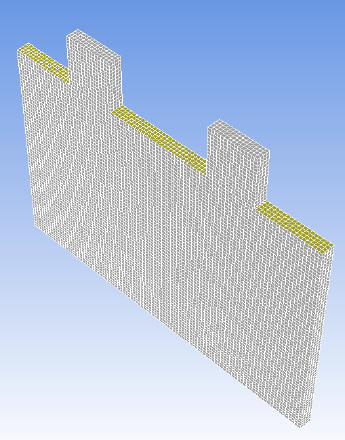
Figure 3. Battery cell geometry, which was analysed in this investigation.